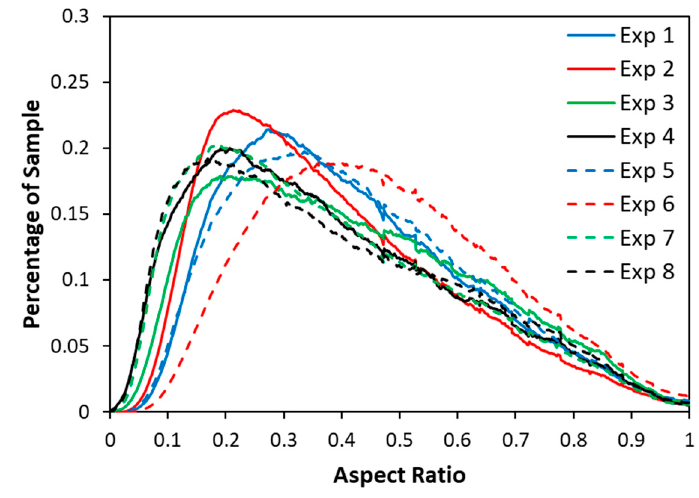
Figure 7. Aspect ratio distribution for each antisolvent crystallisation experiment.